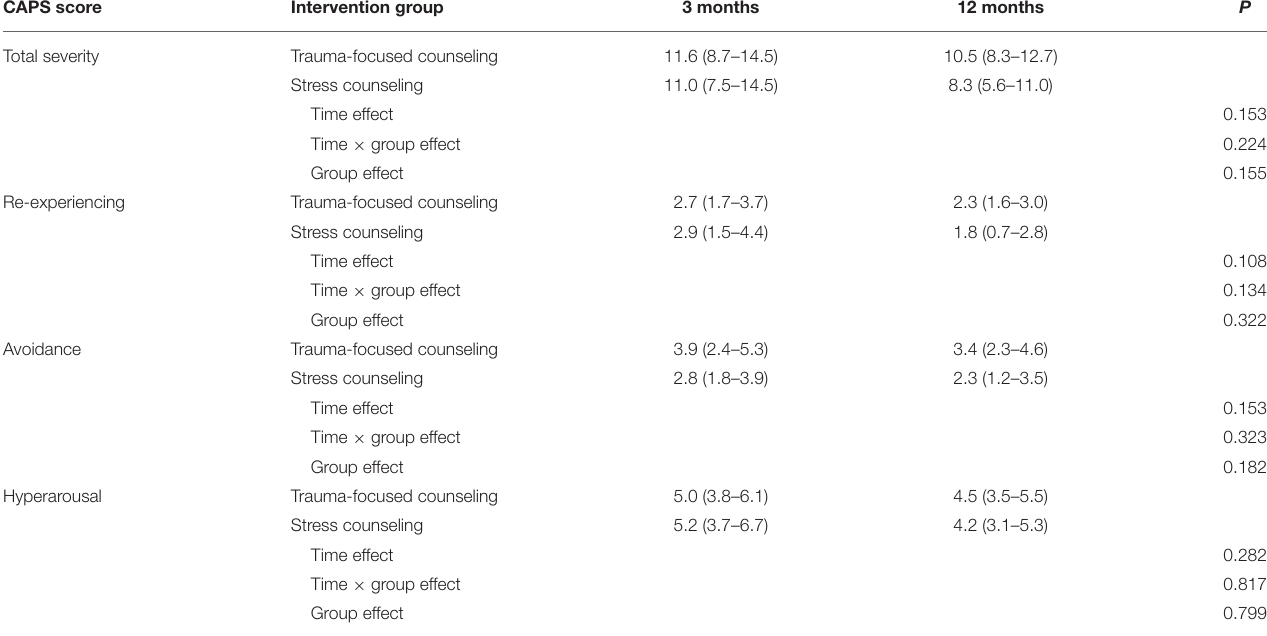
TABLE 2 | Post-traumatic stress symptoms 3 and 12 months after myocardial infarction. CAPS